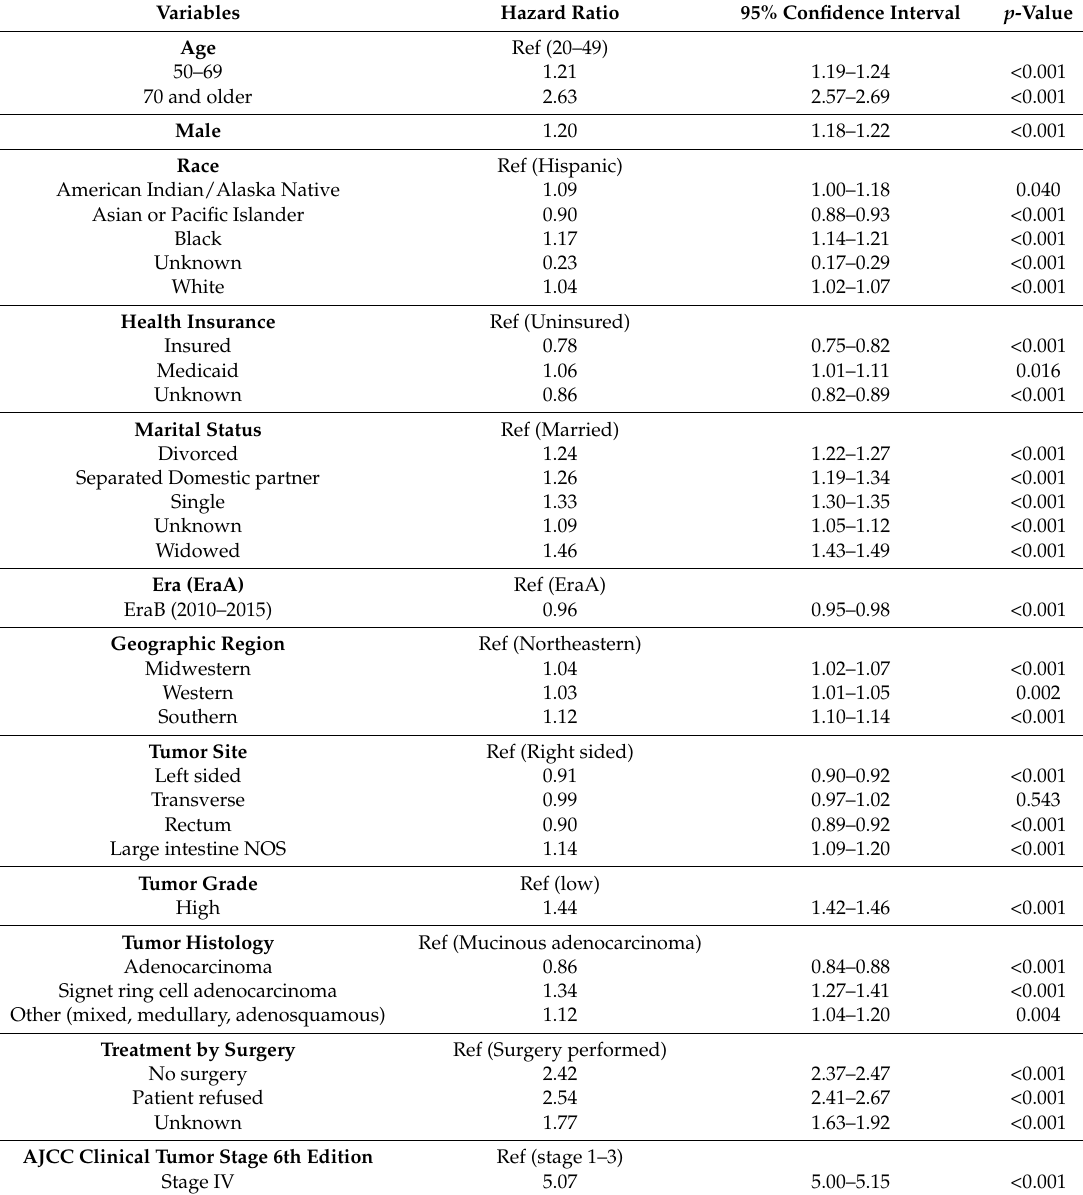
Table 3. Independent predictors of